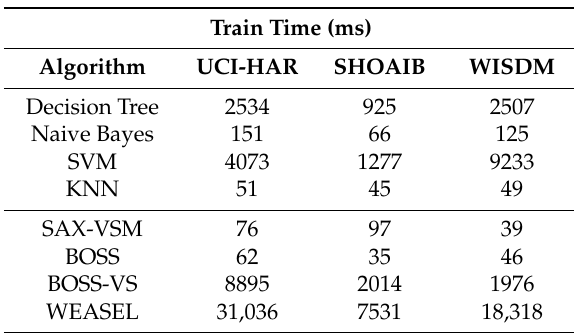
Table 6. List of processing time in the training step of the classification